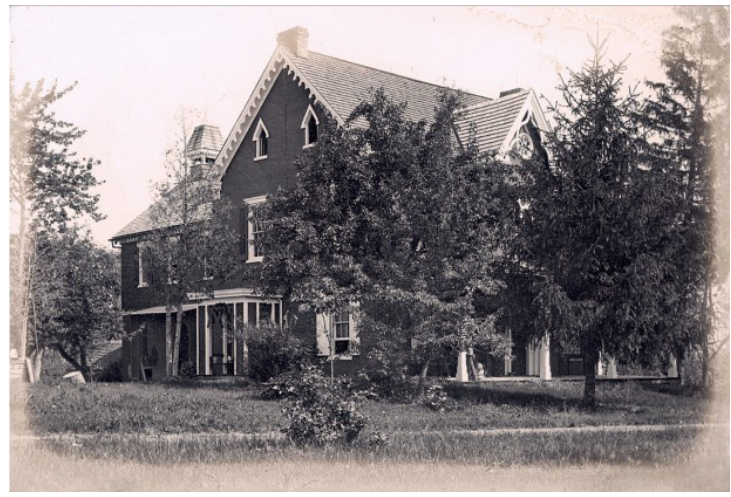
Figure 5. “The Farm House” photograph by John Leslie (Pullyup) from the United States Indian School, Carlisle Pennsylvania , souvenir catalog published in